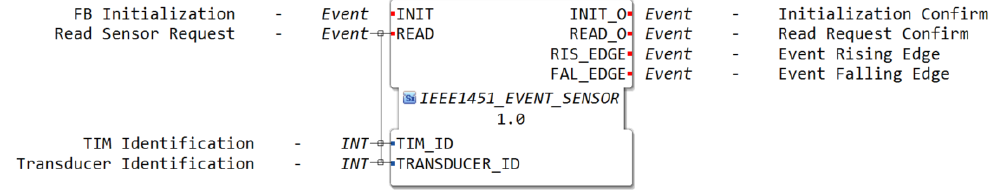
Figure 4. Smart Function Block—IEEE 1451 Event